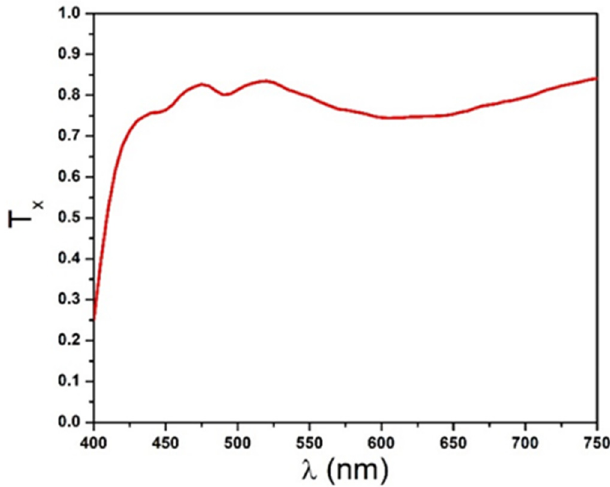
Figure 6. Principal intensity transmittance of the polarizers obtained using Equation (26).